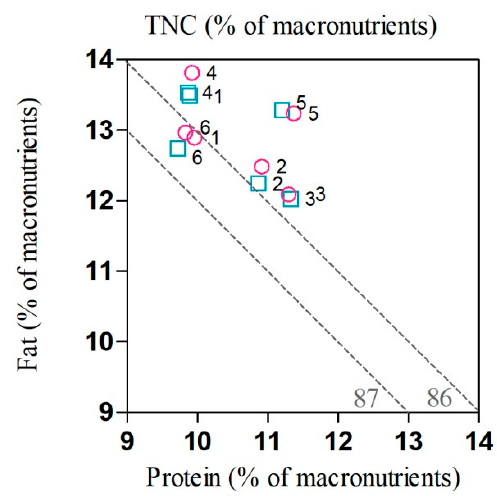
Figure 3. Right-angled mixture triangle showing the macro-nutrient balance in the diet of female (pink) and male (blue) moose at Mohe ( 1 ), Nanwenghe ( 2 ), Zhanhe ( 3 ), Shuanghe ( 4 ), Hanma ( 5 ), and Meitian ( 6 ). Macro-nutrients are expressed as percentage of total macro-nutrients (protein + fat + total nonstructural carbohydrates (TNC)), % of macro-nutrients. TNC is shown on the implicit z -axis, the value of which is inversely related with distance from the origin.